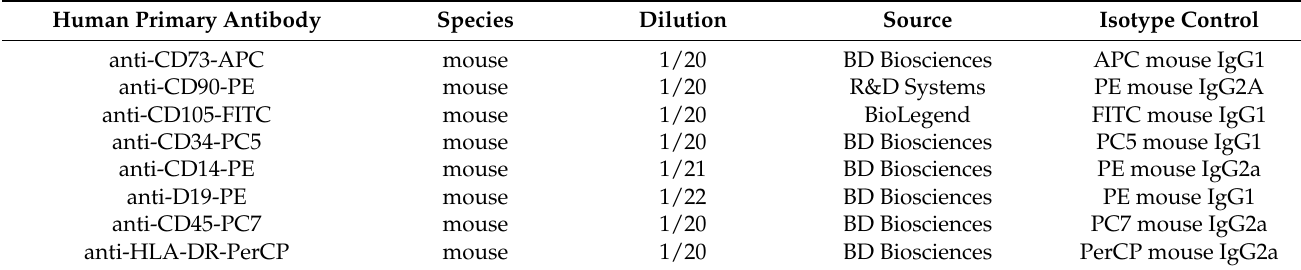
Table 1. List of monoclonal antibodies for flow